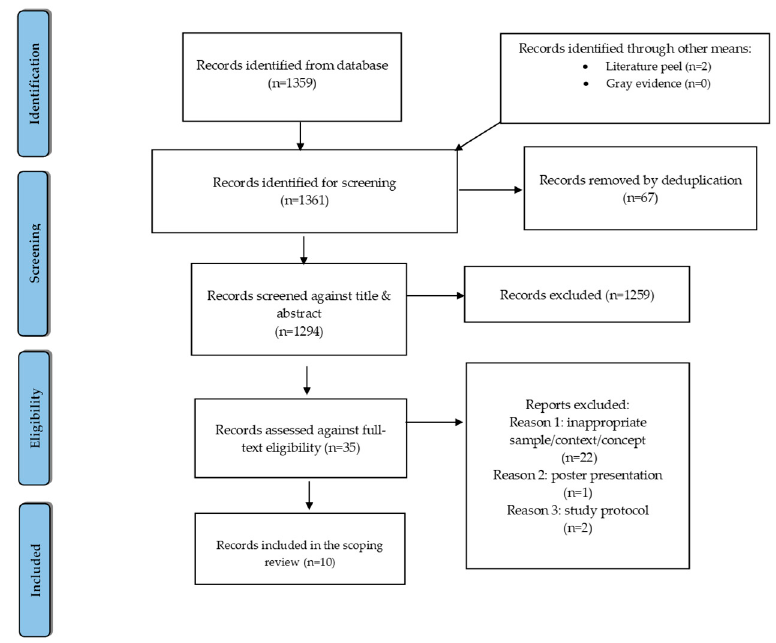
Figure 1. PRISMA flow chart for inclusion and exclusion of studies in this scoping review [27] .